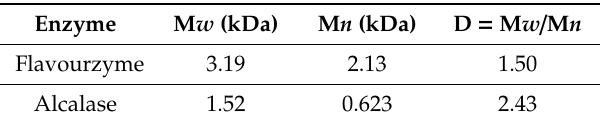
Table 6. Results M w , M n and the multiple dispersion index of the molecular weight of soy protein hydrolyzate measured by gel filtration chromatography (GPC). Enzyme M w (kDa) M n (kDa) D = M w / M n